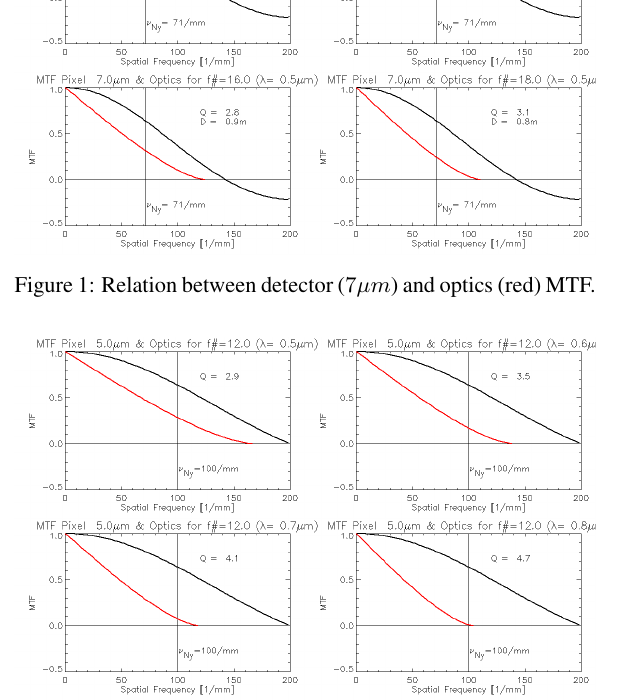
Figure 2: Relation between detector ( 5 µm ) and optics (red)